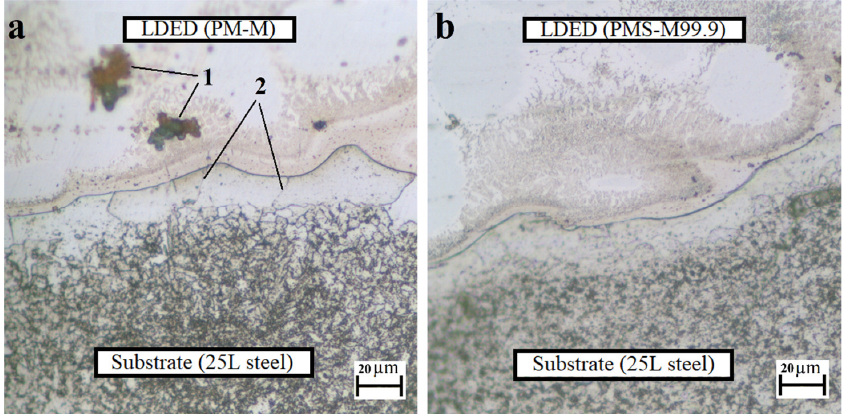
Figure 9. Microstructure of the Mo-steel boundary after LDED (×100): ( a ) powder PM-M; ( b ) powder PMS-M99.9.